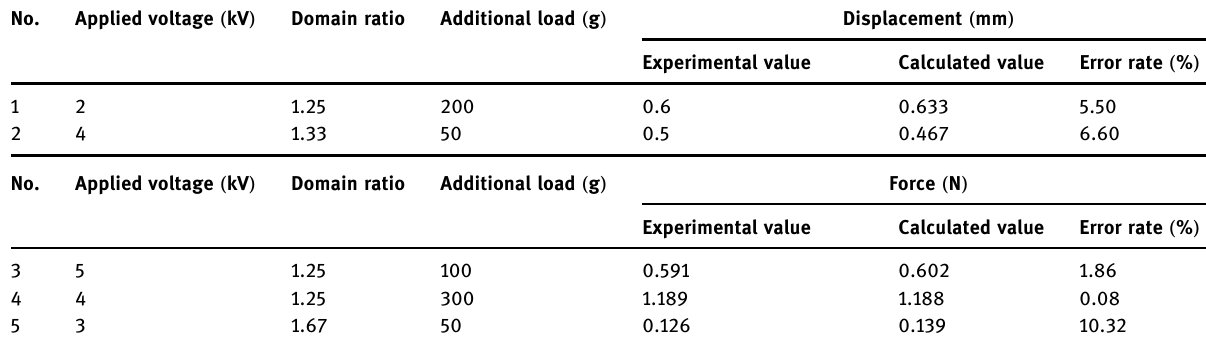
Table 1: Comparison of experimental and calculated values